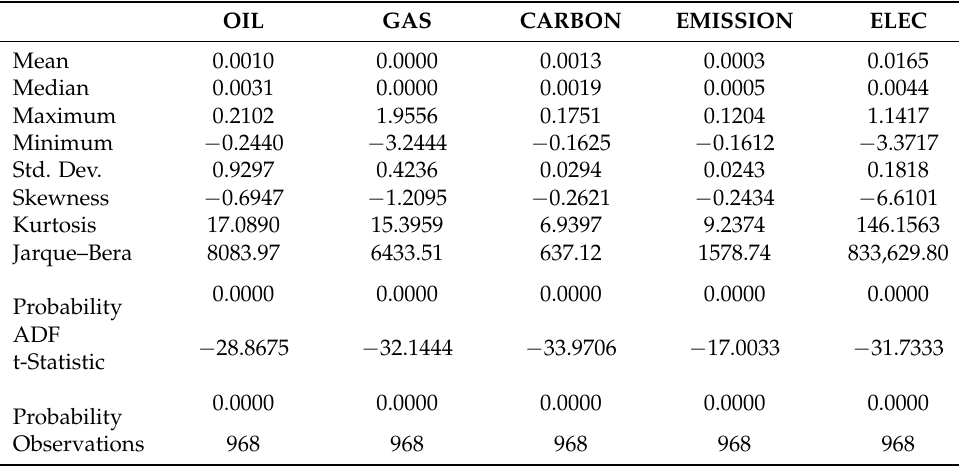
Figure 3. Carbon emissions from different departments. Table 3. Descriptive statistics and stationary tests of other